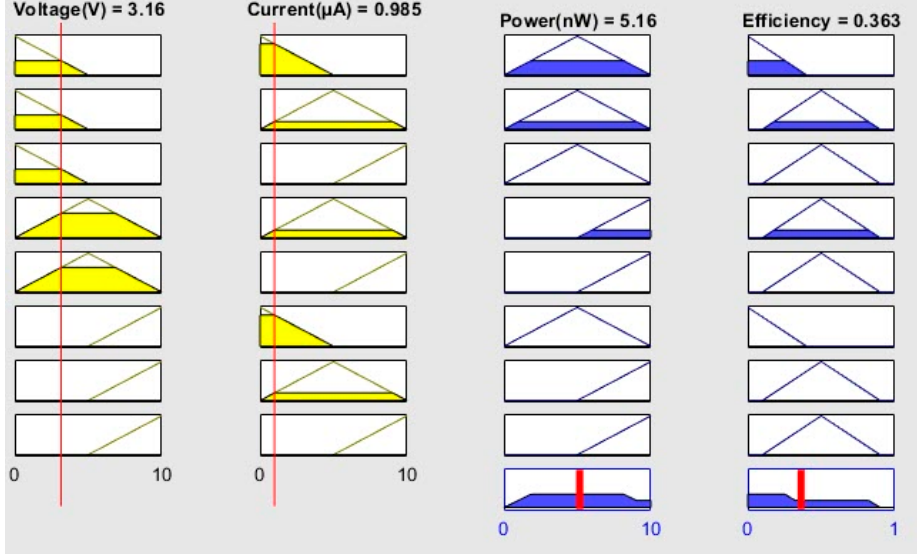
Figure 7. Rule Viewer of EHFLC.